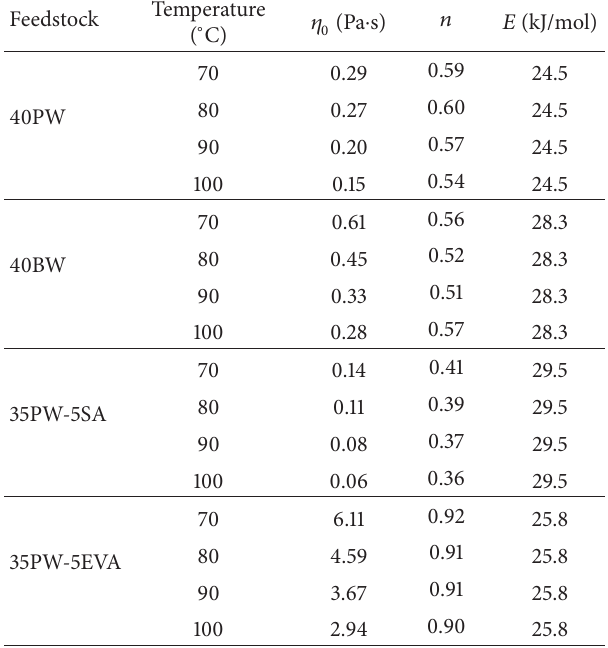
Table 2: Rheological parameters of feedstocks. Feedstock